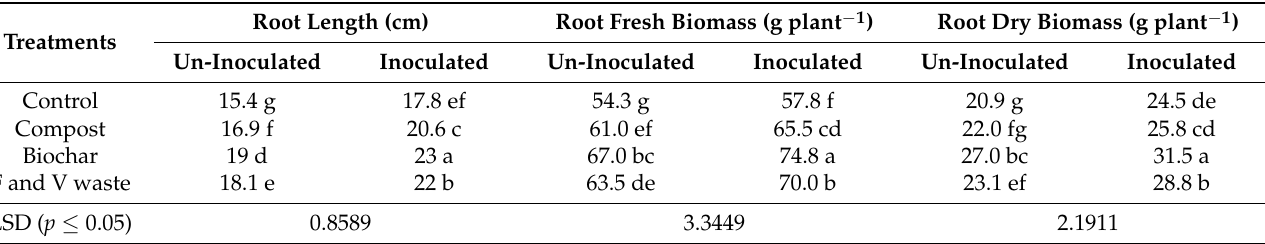
Table 3. Effect of compost, biochar, fruit and vegetable waste (F and V waste) and Bacillus subtilis SMBL 1 on root length, and root fresh and dry biomass of okra.